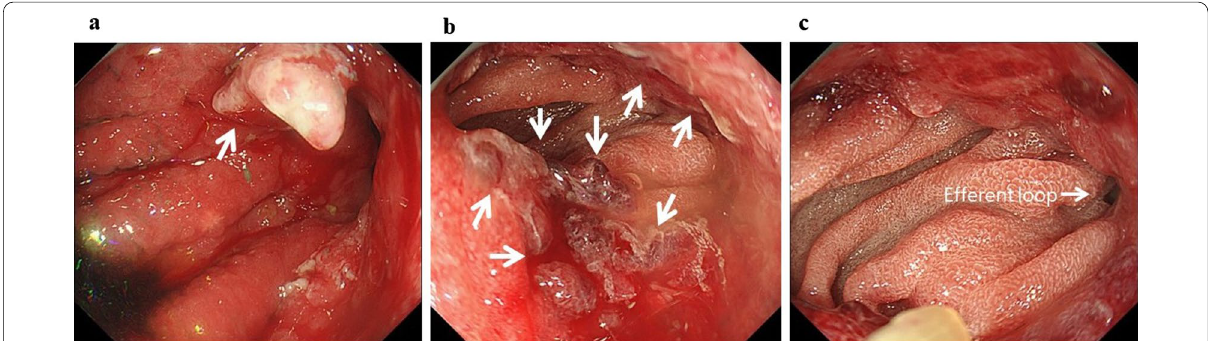
Fig. 2 The pictures of the gastrointestinal fiberscope. a A 2-cm nodular lesion at the anterior wall of the stomach, just near the anastomosis site. b Irregular and hemorrhagic mucosa spread circularly from the nodular lesion to the anastomosed jejunum. c The efferent loop was patent